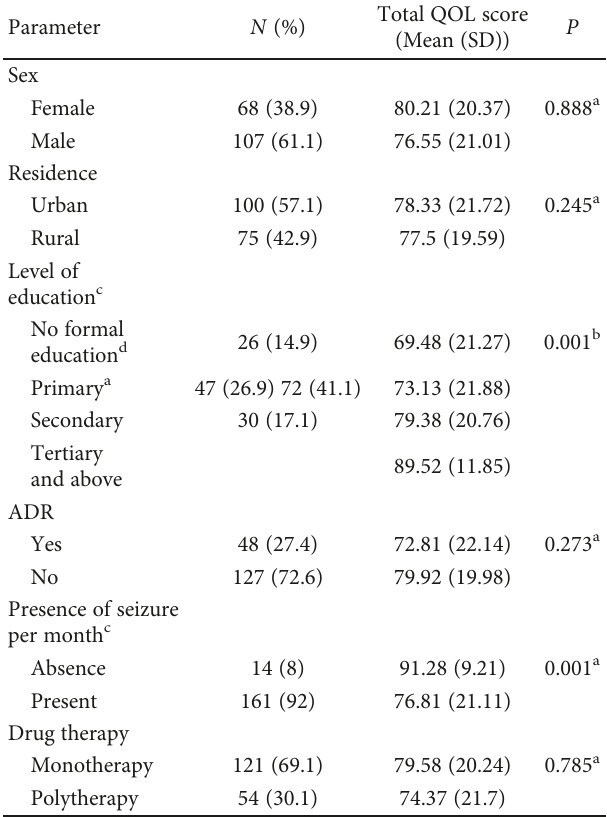
Table 3: Di ff erence of QOL score in epilepsy patient in ACSH and Mekelle Hospital.